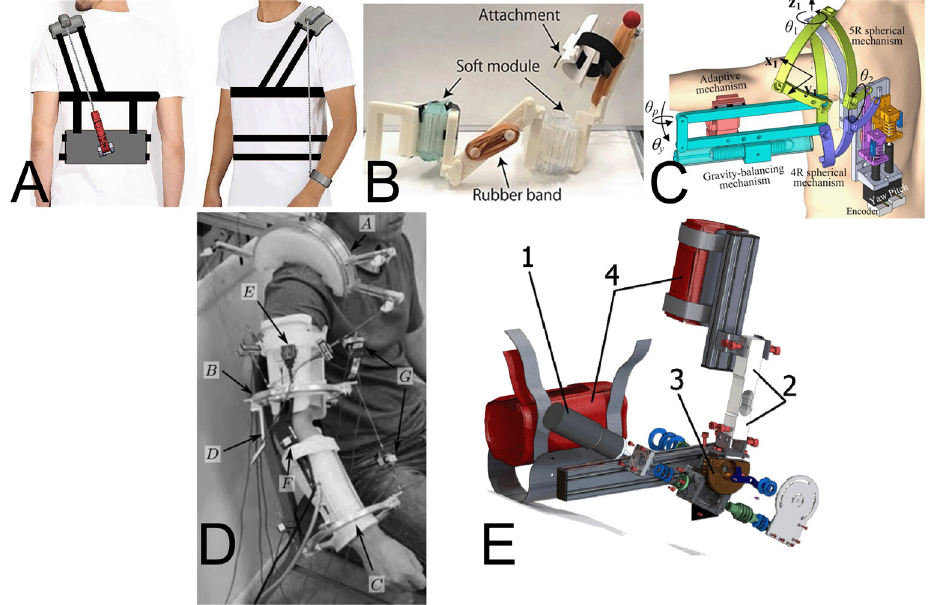
Figure 2. ( A ) Upper-limb exoskeleton for rehabilitation [23], ( B ) exoskeleton actuated by soft